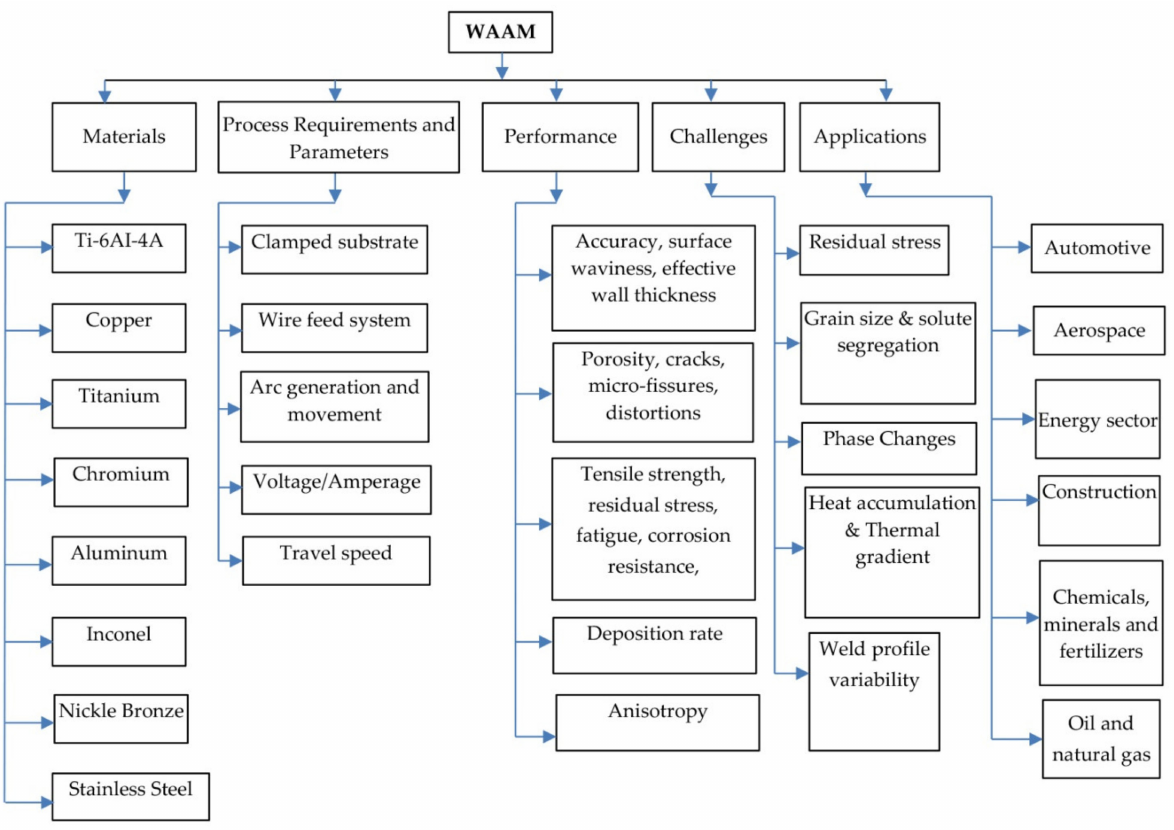
Figure 3. WAAM basics and potential domains of study